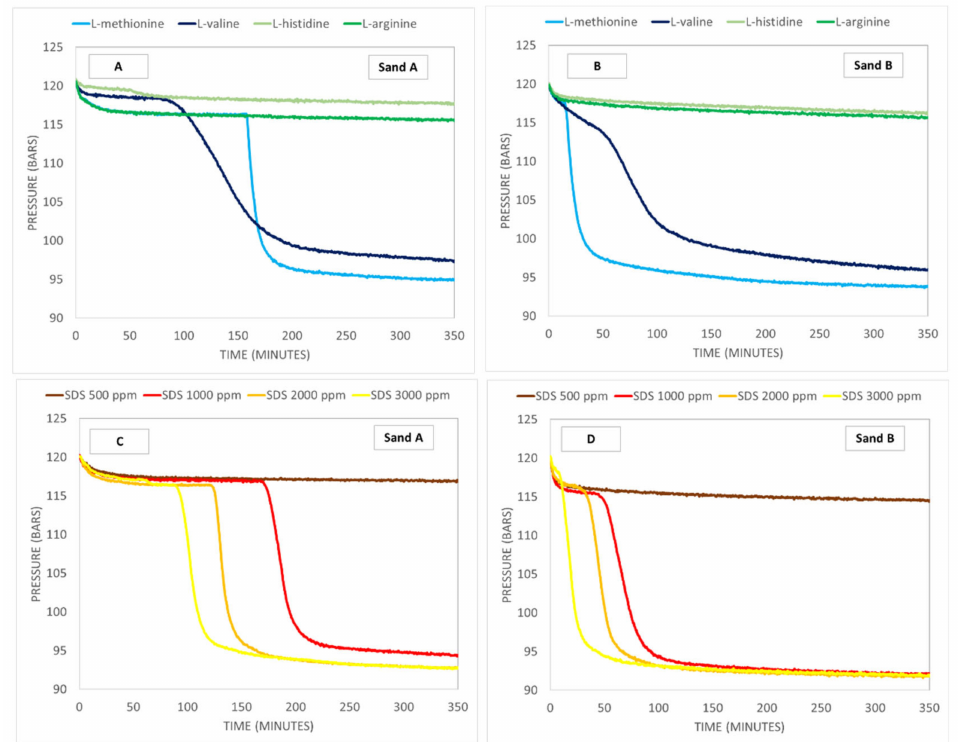
Figure 7. Pressure profiles of CO 2 -rich gas hydrate formation using 30 mol% CO 2 during isothermal experiments at 120 initial bar pressure and 1 ◦ C for four amino acids (3000 ppm) and SDS (500, 1000, 2000, and 3000 ppm) during CGHF with varying sand types (A and B) and gas B. ( A ) Sand A with amino acids, ( B ) Sand B with amino acids, ( C ) Sand A with SDS, and ( D ) Sand B with